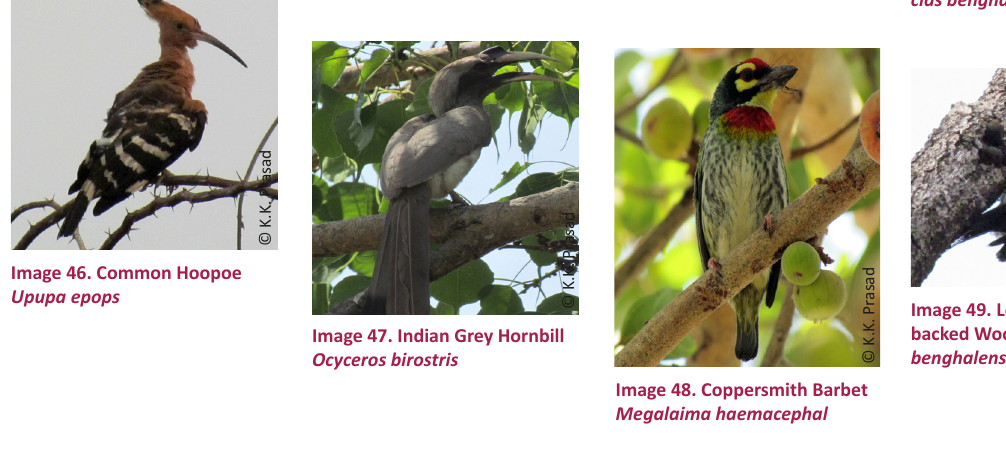
Image 43. Small Bee-eater Merops orientalis